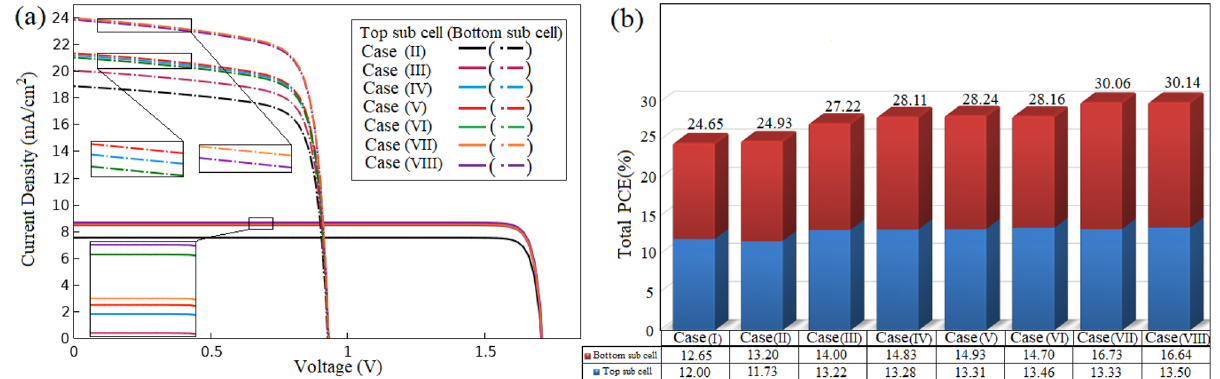
Figure 11. ( a ) The current-voltage characteristics of the proposed cases (II)–(VIII). ( b ) The PCE of each sub cell and the 4T structure for all proposed except in the range of 870–930 nm, which is referred to as the DI between incident light and reflected light from the surfaces. Consequently, the absorption is decreased in the NBG perovskite layer (comparison of blue and green lines in Fig. 10a,b). As shown in Fig. 10b, the most reflection losses are related to the second half of the spectrum. Since this range corresponds to the sensitivity range of absorption in the NBG perovskite layer, a part of the entered sunlight into this layer has not been absorbed and it has left the device. In order to increase the absorption ability, we exploited nano-plasmonic structures. To use the back-scattering effects of the nano-plasmonic structure, the size of the pattern located at the HTM/back-contact interface is assumed to be greater than 50 nm. Because the HTM layer is 50 nm thick, all top layers of the Ag-back contact in the bottom sub cell are also patterned without changing the thickness of the ARL and absorber layer. Thus, both nano-photonic and nano-plasmonic structures are employed. According to the absorption and the reflection spectra of cases (V) and (VII) (red and orange lines in Fig. 10a,b), no noticeable change is observed in the absorption of the WBG absorber layer, the first half of the absorption spectrum of the NBG absorber layer, and the first half of the total reflection. However, in the second half of the absorption spectrum related to the absorber layer of the bottom sub cell, the absorption enhancement occurred at wavelengths ranging of 630–710 and 740–970 nm. It is due to the scattering mechanisms caused by nano-photonic and nano-plasmonic structures. Nano-texture structures increase the optical path-length. There- fore, absorption of the NBG perovskite layer is enhanced. Also, total reflection losses are reduced in these ranges, implying that sunlight rarely leaves the device; it remains in the device due to the forward-scattering mechanism By combining two cases (VI) and (VII), the features of these two cases are incorporated. This structure is introduced as case (VIII). As expected, similar behavior can be seen in the absorption spectrum of the WBG perovskite layer in cases (VI) and (VIII) (green and violet lines in Fig. 10a). Comparing the absorption spec- trum of case (VII) with case (VIII) (orange and violet lines in Fig. 10a) shows that the absorption is improved at